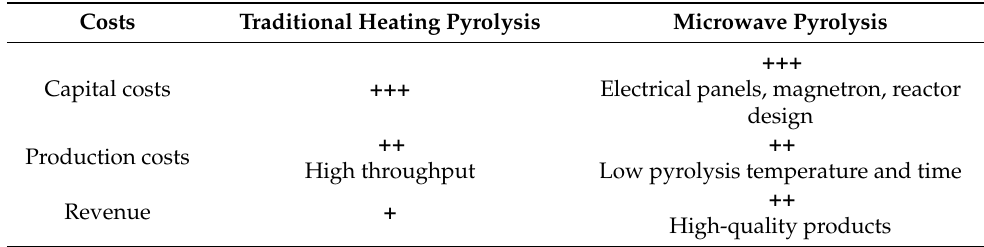
Table 9. Comparison of costs of traditional heating pyrolysis and microwave pyrolysis [135]. Costs Traditional Heating Pyrolysis Microwave Pyrolysis +++ Capital costs +++ Electrical panels, magnetron, reactor design ++ ++ Production costs High throughput Low pyrolysis temperature and time ++ Revenue + High-quality products + low, ++ moderate, +++